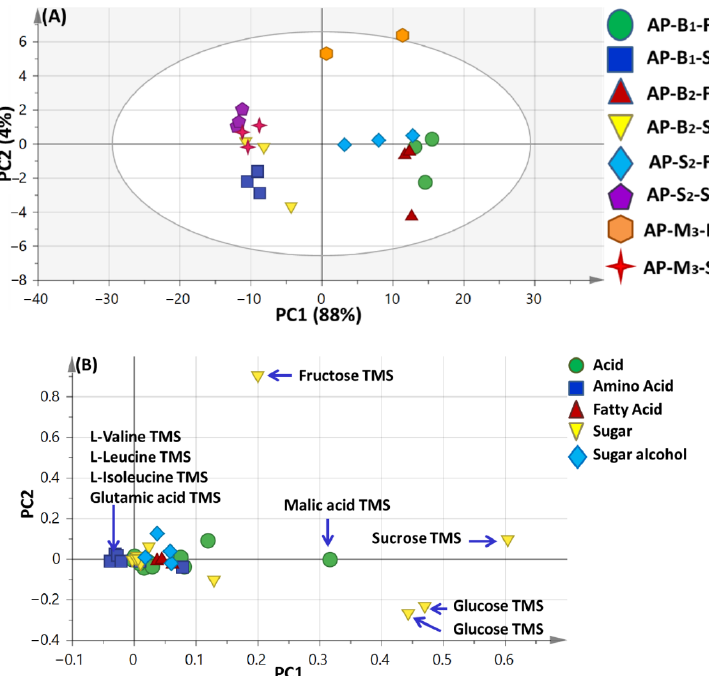
Figure 2. Principal component analyses of silylated metabolites in seed kernel and fruit extracts as analyzed by GC-MS ( n = 3). ( A ) Score plot of PC1 vs. PC2 scores. ( B ) Loading plot for PC1 and PC2 contributing mass peaks and their assignments. AP-B1-F; Manshiet Al-Ammar bitter apricot fruits (Muddy soil), AP-B1-S; Manshiet Al-Ammar bitter apricot seeds (Muddy soil), AP-B2-F; Al-Amar Al-Kubra bitter apricot fruit (Muddy soil), AP-B2-S; Al-Amar Al-Kubra bitter apricot seed (Muddy soil), AP-M3-F; Nubaria mountain bitter apricot fruit (Sandy soil), AP-M3-S; Nubaria mountain bitter apricot seed (Sandy soil), AP-S2-F; Al-Amar Al-Kubra sweet apricot fruit (Muddy soil), AP-S2-S; Al-Amar Al-Kubra sweet apricot seed (Muddy soil) An obvious segregation between apricot seed kernels from fruits could be observed along PC1, with apricot seed kernel specimens positioned with negative score values (left side in PC1), whereas apricot fruit specimens clustered with positive score values (right side in PC1). Examination of the loading plot (Figure 2B) revealed that sugars viz. fructose, sucrose and glucose as well as acids viz . malic acid contributed the most for apricot fruit specimens’ segregation with glucose, sucrose and fructose serving as major contributors to fruit sweetness, whereas amino acids viz. valine, leucine, isoleucine and glutamic acids found more abundant in apricot seed kernels suggestive for the sour taste of seed kernels compared to fruits. 3.2.1. Multivariate Data Analyses of the Primary Silylated Metabolites in Fruits and Seed Kernels Models For better segregation and to help identify variation within each organ, apricot seed kernel and fruit specimens were modeled separately one at a time (Supplementary Figure S1(A) and Figure S2(A), respectively. The seed kernels PCA model was illustrated by two